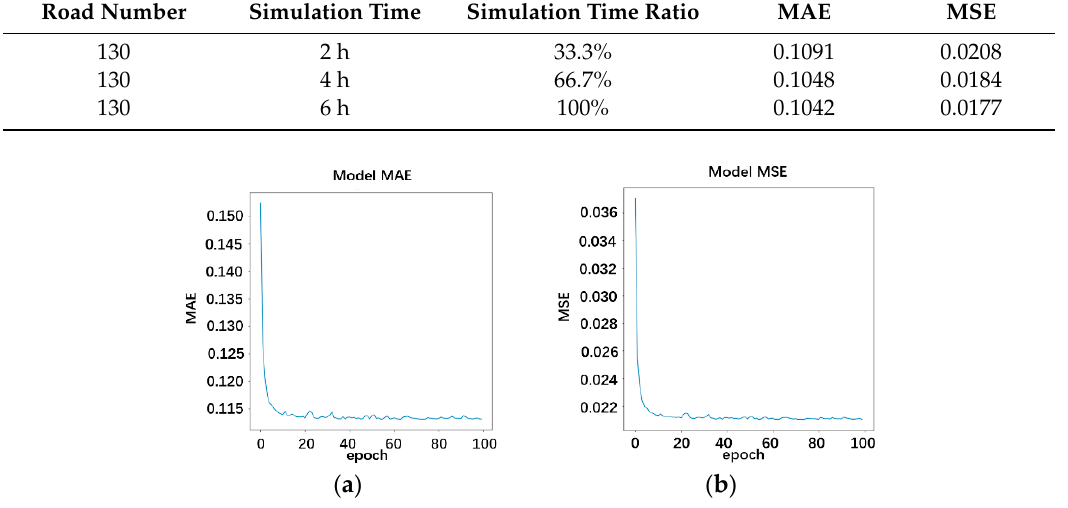
Figure 6. Model training error of 25% road quantity: ( a ) model mean absolute error (MAE); ( b ) model mean square error (MSE).